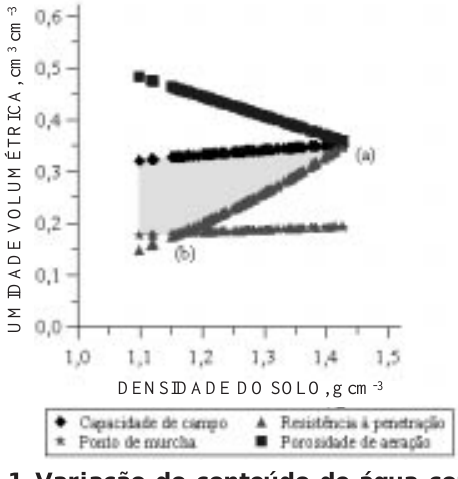
Figura 1. Variação do conteúdo de água com a densidade do solo nos níveis críticos da capacidade de campo ( yyyyy = 0,01 MPa), ponto de murcha permanente ( yyyyy = 1,5 MPa), porosidade de aeração de 10 % e resistência à penetração de 3,0 MPa no Latossolo Vermelho distrófico estudado. A área hachurada representa o Intervalo Hídrico Ótimo (IHO). A densidade crítica ( Dsc ), em que o IHO = 0, é demonstrada em (a), e a densidade em que a resistência à penetração substitui o ponto de murcha permanente como limite inferior do IHO em